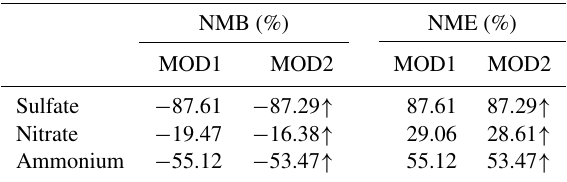
Table 4. Validation statistics of SIAs in PM 2 . 5 at